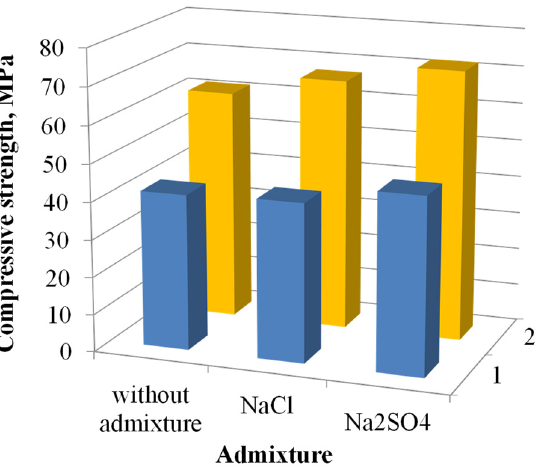
Figure 1. The 28-day compressive strength of the alkali-activated slag cement concretes mixed